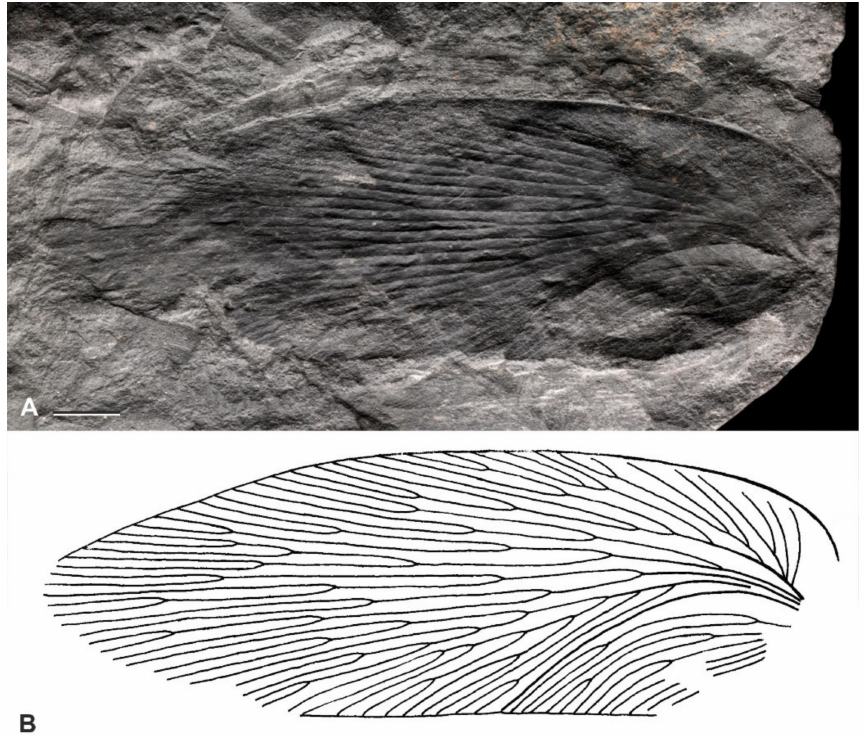
Figure 13. ( A , B )— Progonoblattina helvetica (Heer, 1864): type specimen of ‘ Necymylacris boulei ’ Agnus, 1903a; Grande Couche; MNHN 48303; length 59 mm; scale bar 5 mm; photo: